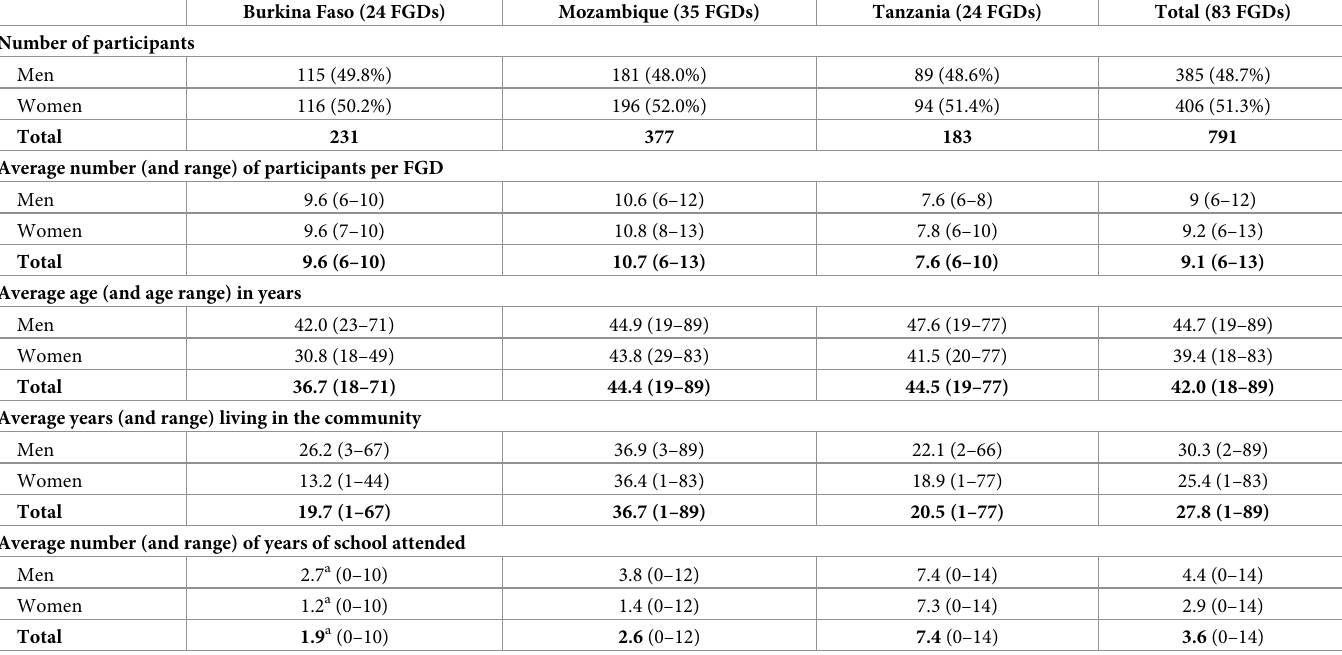
Table 2. Study participants. Number of focus group discussion (FGD) study participants and their socio-demographic characteristics by country and in total. Burkina Faso (24 FGDs) Mozambique (35 FGDs) Tanzania (24 FGDs) Total (83